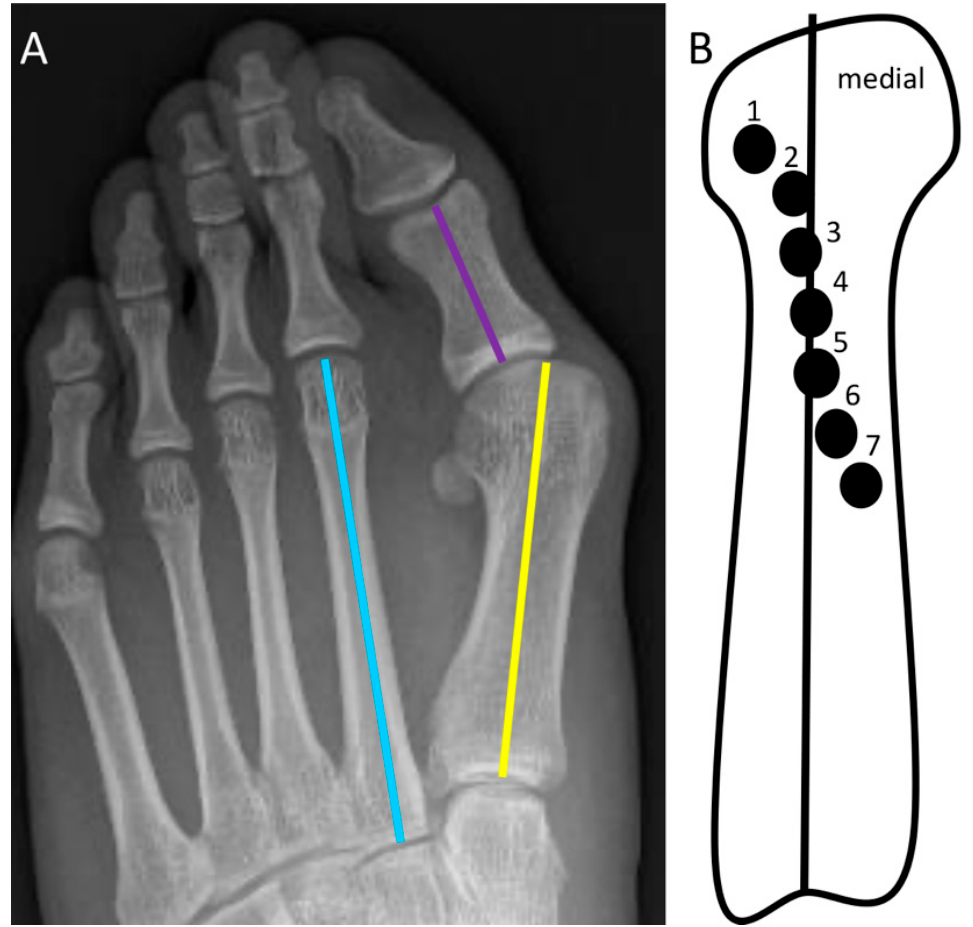
Figure 1. ( A ) Anteroposterior (AP) radiograph of the foot demonstrating the longitudinal axis of the first metatarsal (yellow line), first proximal phalanx (purple line), and second metatarsal (blue line). IMA is the angle between the first and second metatarsal longitudinal axes. HAA is the angle between the first metatarsal and first proximal phalangeal longitudinal axes. ( B ) Schematic of MSP, typically measured on a 7-point scale that increases with progressive medial angulation of the first metatarsal.